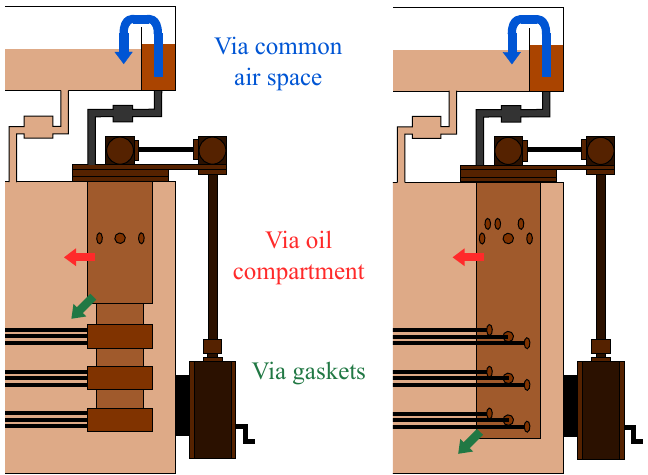
Figure 4. Types of oil compartments used by different OLTC designs [32].